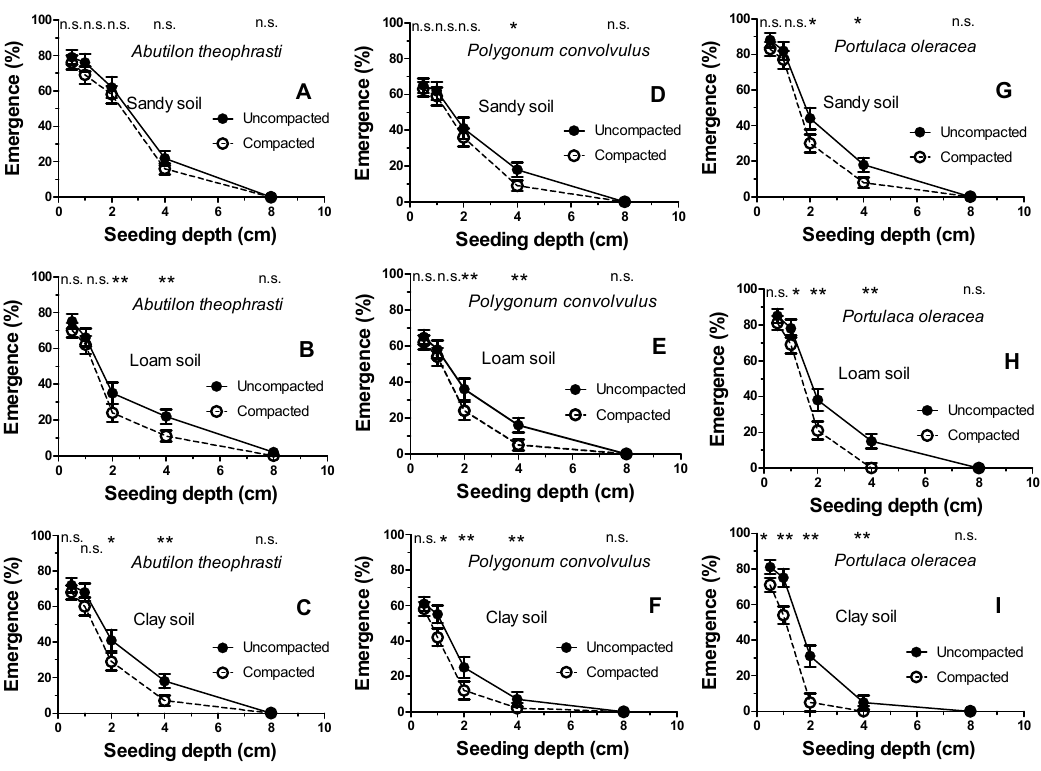
Figure 2. Seedling emergence of the three selected weeds as a function of sowing depth (0.5, 1, 2, 4, and 8 cm), texture (sandy ( A , D , G ), loam ( B , E , H ), and clay soil ( C , F , I )) and soil compaction. Single or double asterisks indicate the significance level of pairs of data (each soil depth) in the Student–Newman–Keuls test ( p < 0.05 or p < 0.011, respectively).